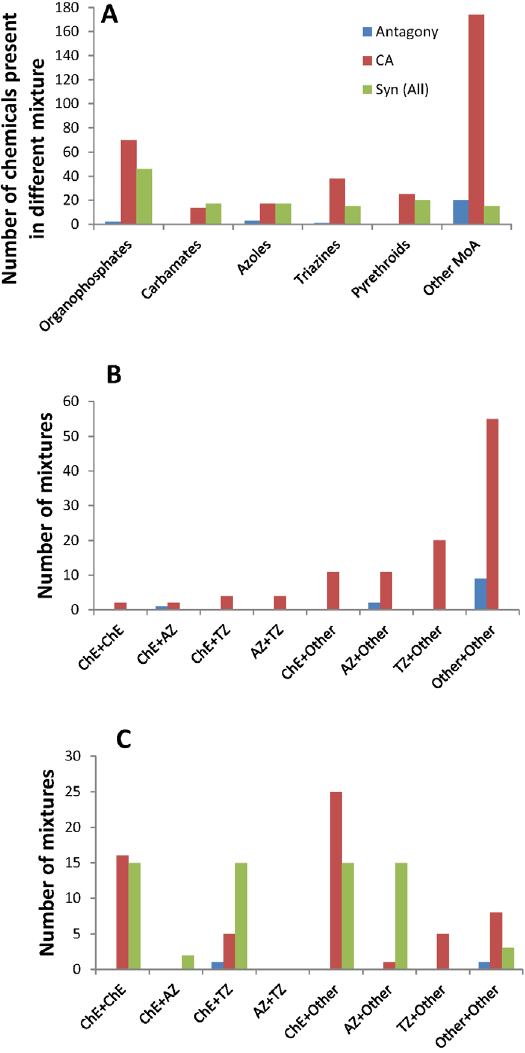
Figure 3. Frequency of pesticide antagony, additivity and synergy. Figure 2A shows the number of times a pesticide belonging to the group of organophosphates, carbamates, azoles, triazines, pyrethroids or some other Mode of Action (other MoA) occur in a binary mixture resulting in antagony (blue bars), concentration additivity (CA) (red bars) or synergy (green bars). In figure B and C, the number of binary combinations of cholinesterase inhibitors (ChE) (The organophosphates and carbamates), azoles (AZ), triazines (TZ) and other Modes of Action (Other) resulting in either antagony, concentra- tion additivity or synergy are shown for mixtures tested on B) auto- tropic organisms (plants and algae, n =120) or C) heterotrophic organisms (microorganisms and animals, n